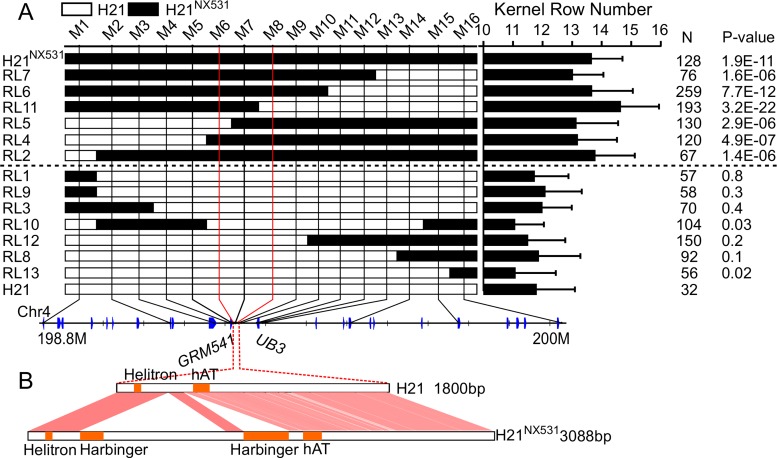
Fine mapping of KRN4.A) The graphical genotypes of homozygous recombinants (HR). The white boxes in the graphical genotype represent the genomic segments from H21, the black boxes represent genomic segments from H21NX531. A progeny test was conducted to examine whether the KRN of HRs were significantly higher than that of H21. N: the total number of HR phenotyped in four environments (S1 Dataset). P-value: Student’s t-test of the difference in KRN between HRs and H21. The axis represents the physical map of KRN4, and the blue box represents genes within KRN4. B) Nucleotide sequence differences in the KRN4 region between H21 and H21NX531. The orange solid boxes represent the locations of transposable elements in KRN4.The shadowed regions represent homologous KRN4 sequence between H21 and H21NX531 (S2 Dataset).